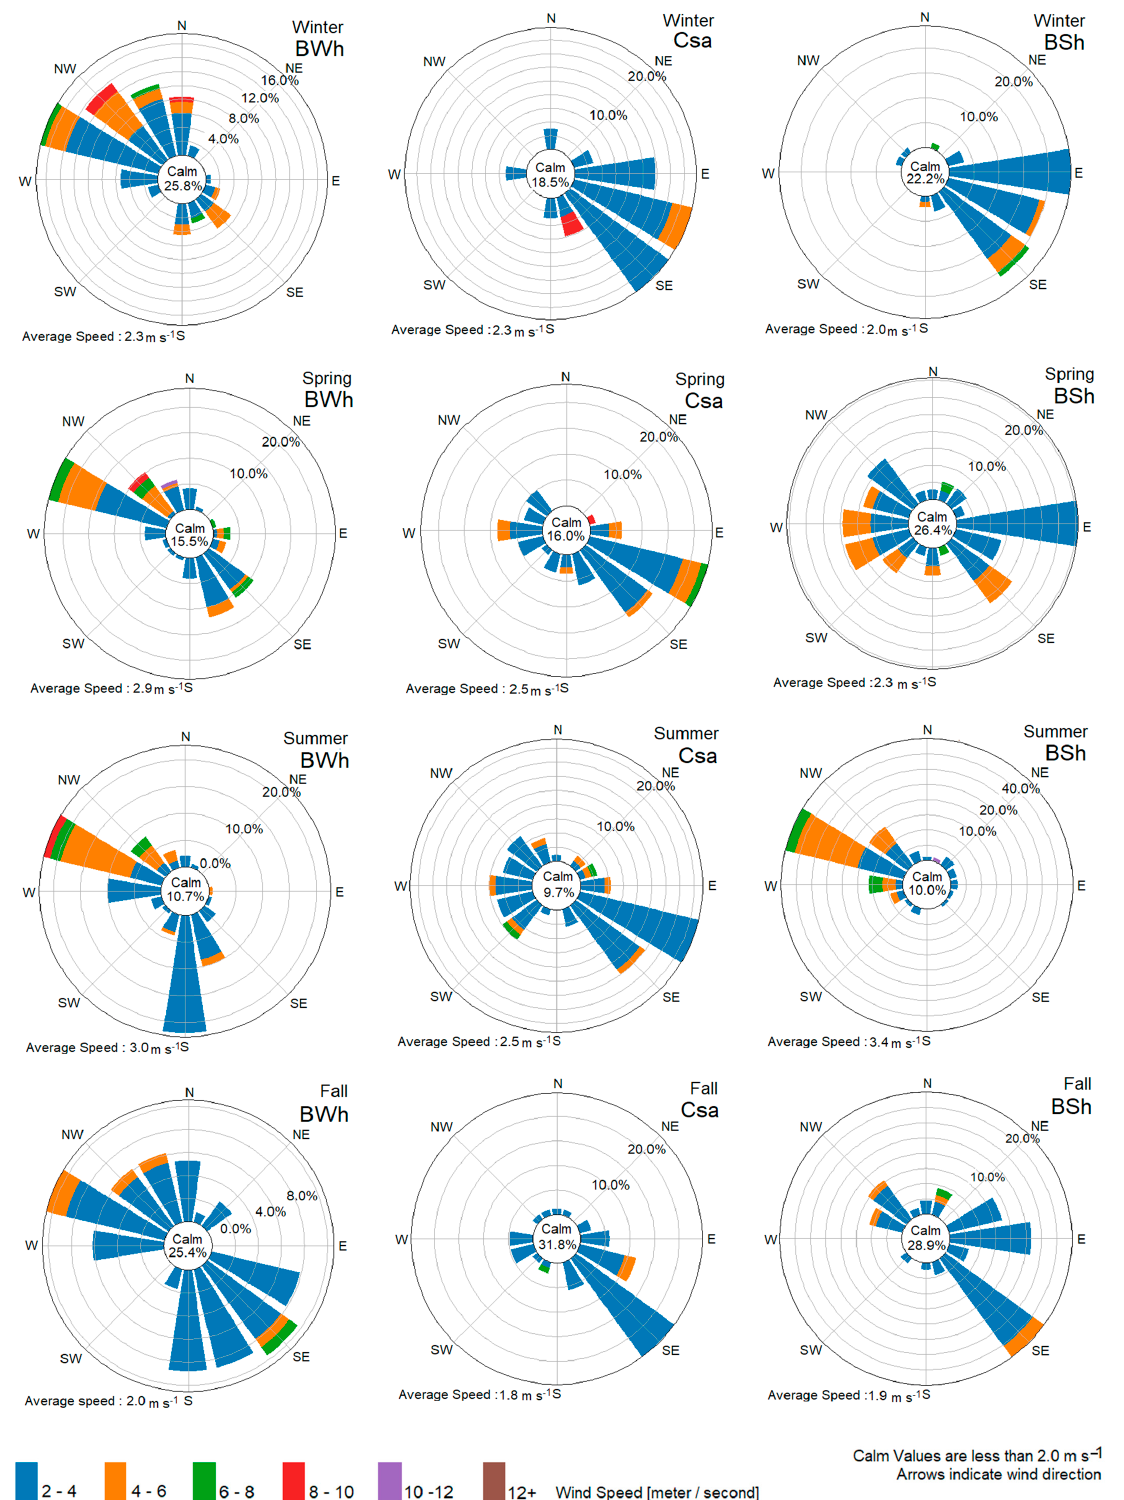
Figure 7. Seasonal wind-roses for BWh, Csa, and BSh climate zones, illustrating the percentage of time that winds blow from a particular direction at a certain speed. The wind rose maps contain centroid circles, wherein the small circle in the center is the calm value in percent of total wind speed, which occurs when speeds are less than 2.0 m s − 1 . The centroid circles (track) relative to the eight wind sectors represent wind severity and directions. Different color arrows signify different wind speeds, as shown in the legend.